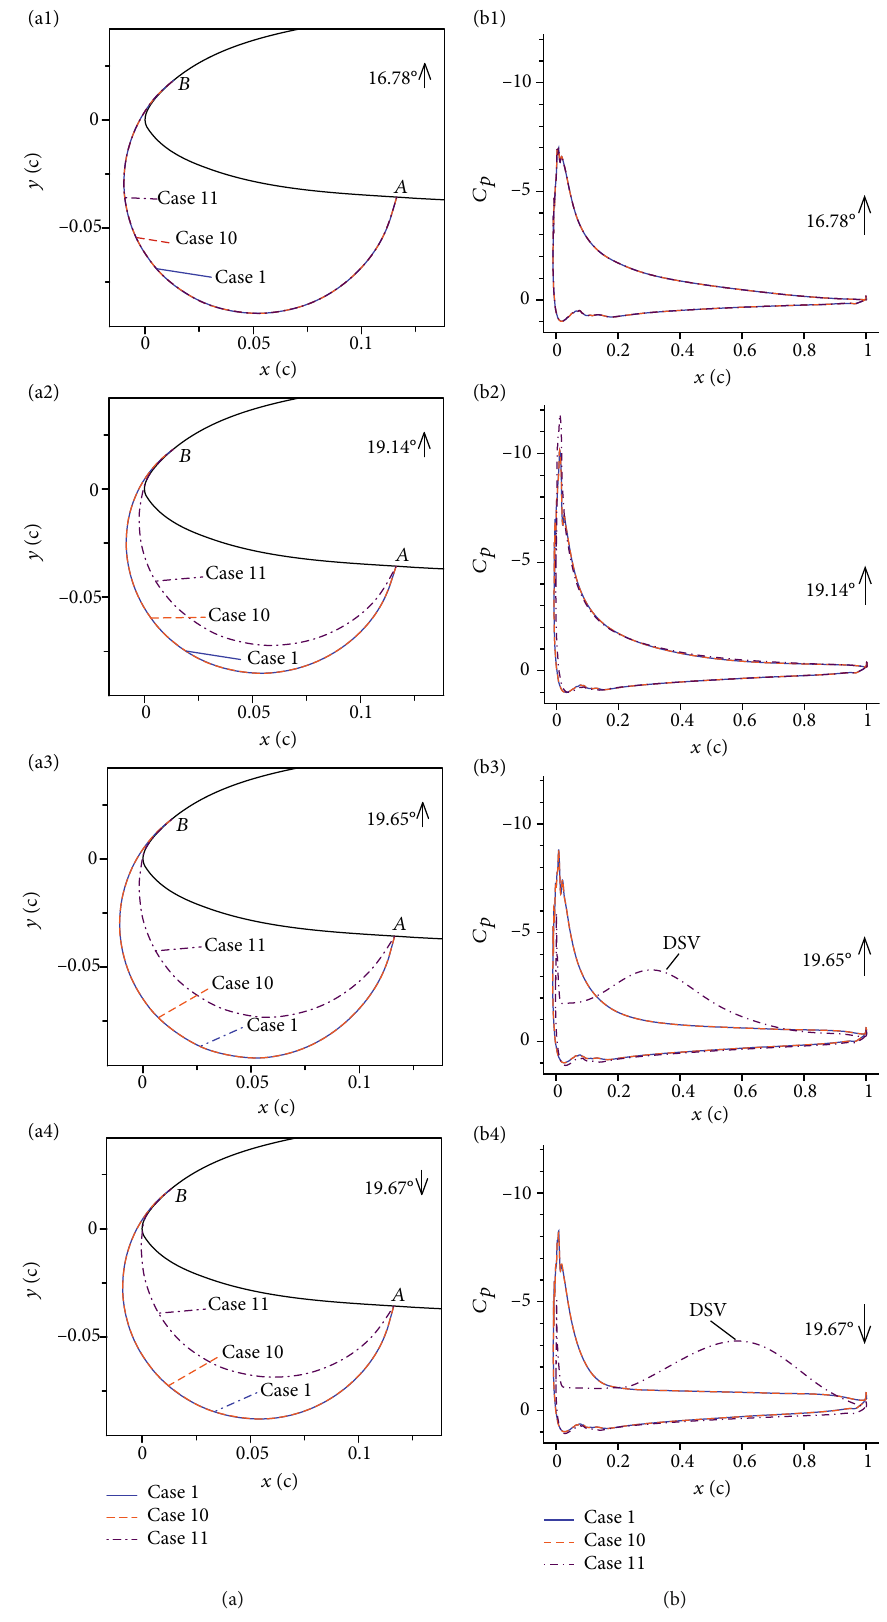
Figure 38: Comparison of ILE shapes and pressure coe ffi cient distributions at di ff erent angles of attack for Cases 1, 10, and